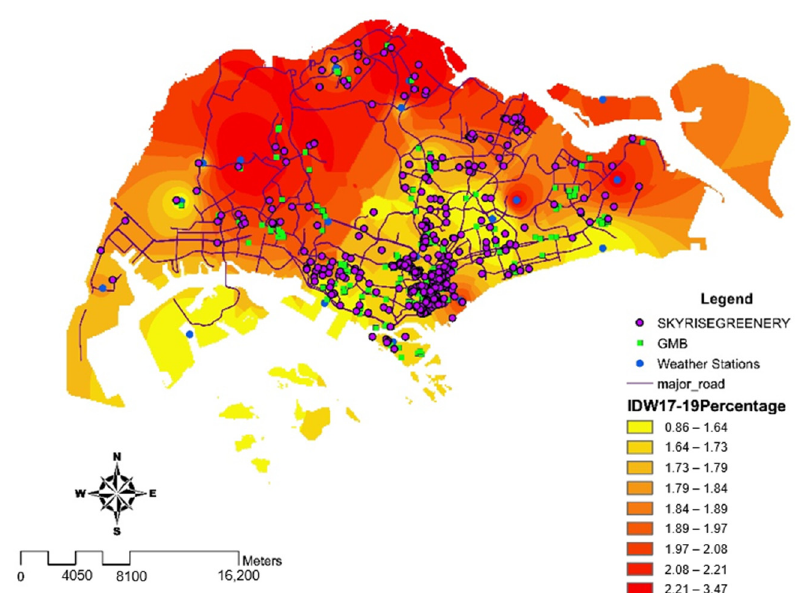
Figure 9. Temperature heatmap to show increase in percentage change in Singapore from 2017 to 2019. Inverse distance weighted (IDW) interpolation is used to calculate the percentage change in temperature based on a set of data calculated from meteorological stations using a linearly weighted combination.